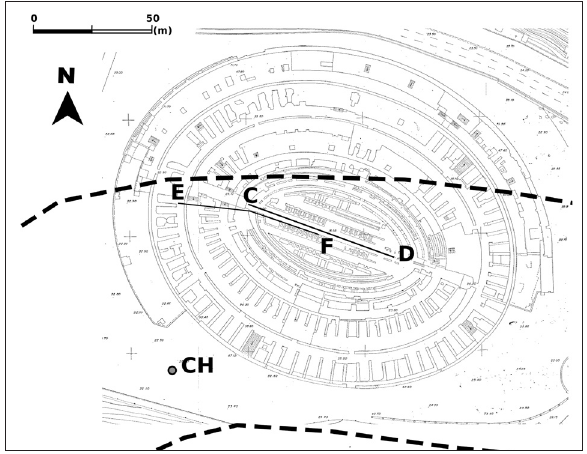
Figure 2. Location of the geophysical investigations: Crosshole CH, ERT lines CD and EF. The black dashed lines represent the limits of the Fosso Labicano Valley as in Figure 1.